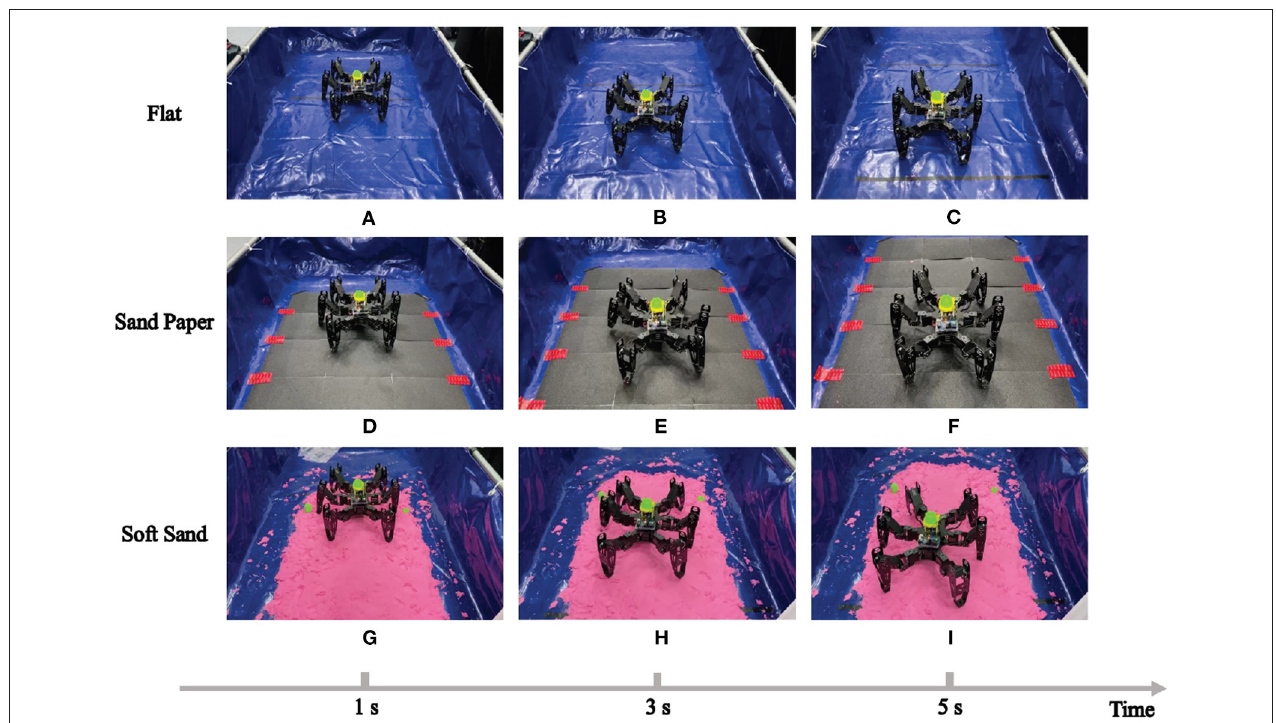
FIGURE 12 | The RL training experiment in different